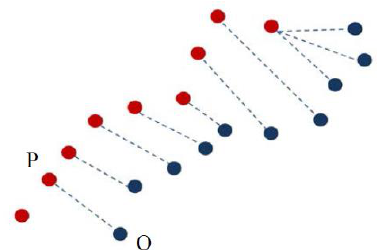
Figure 4. Correspondence estimation between undeformed reference point cloud data P and deformed point cloud data Q (Jafari, 2016)